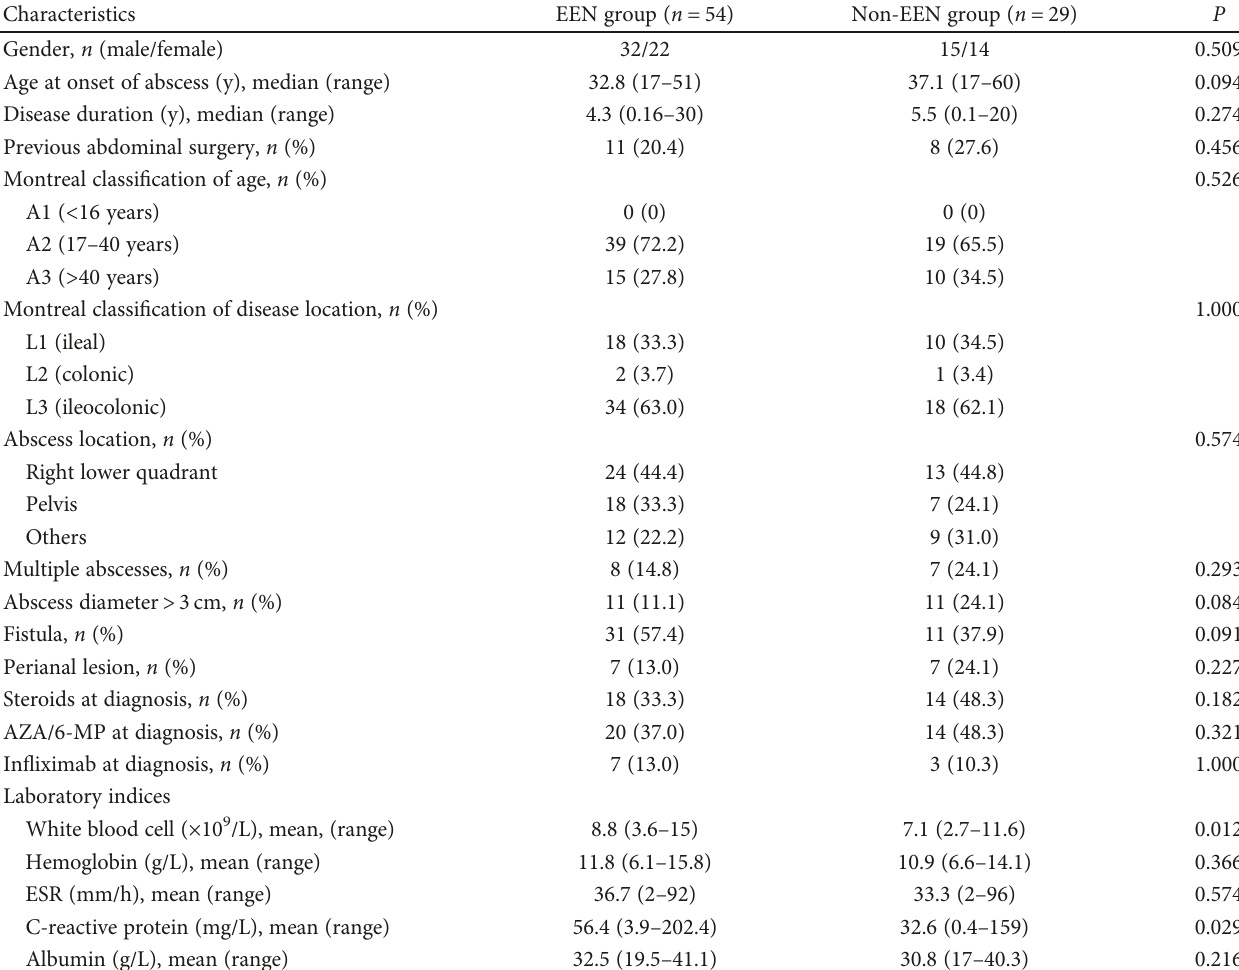
Table 1: Demographic and clinical characteristics of CD patients with percutaneously undrainable abscesses by the treatment group.